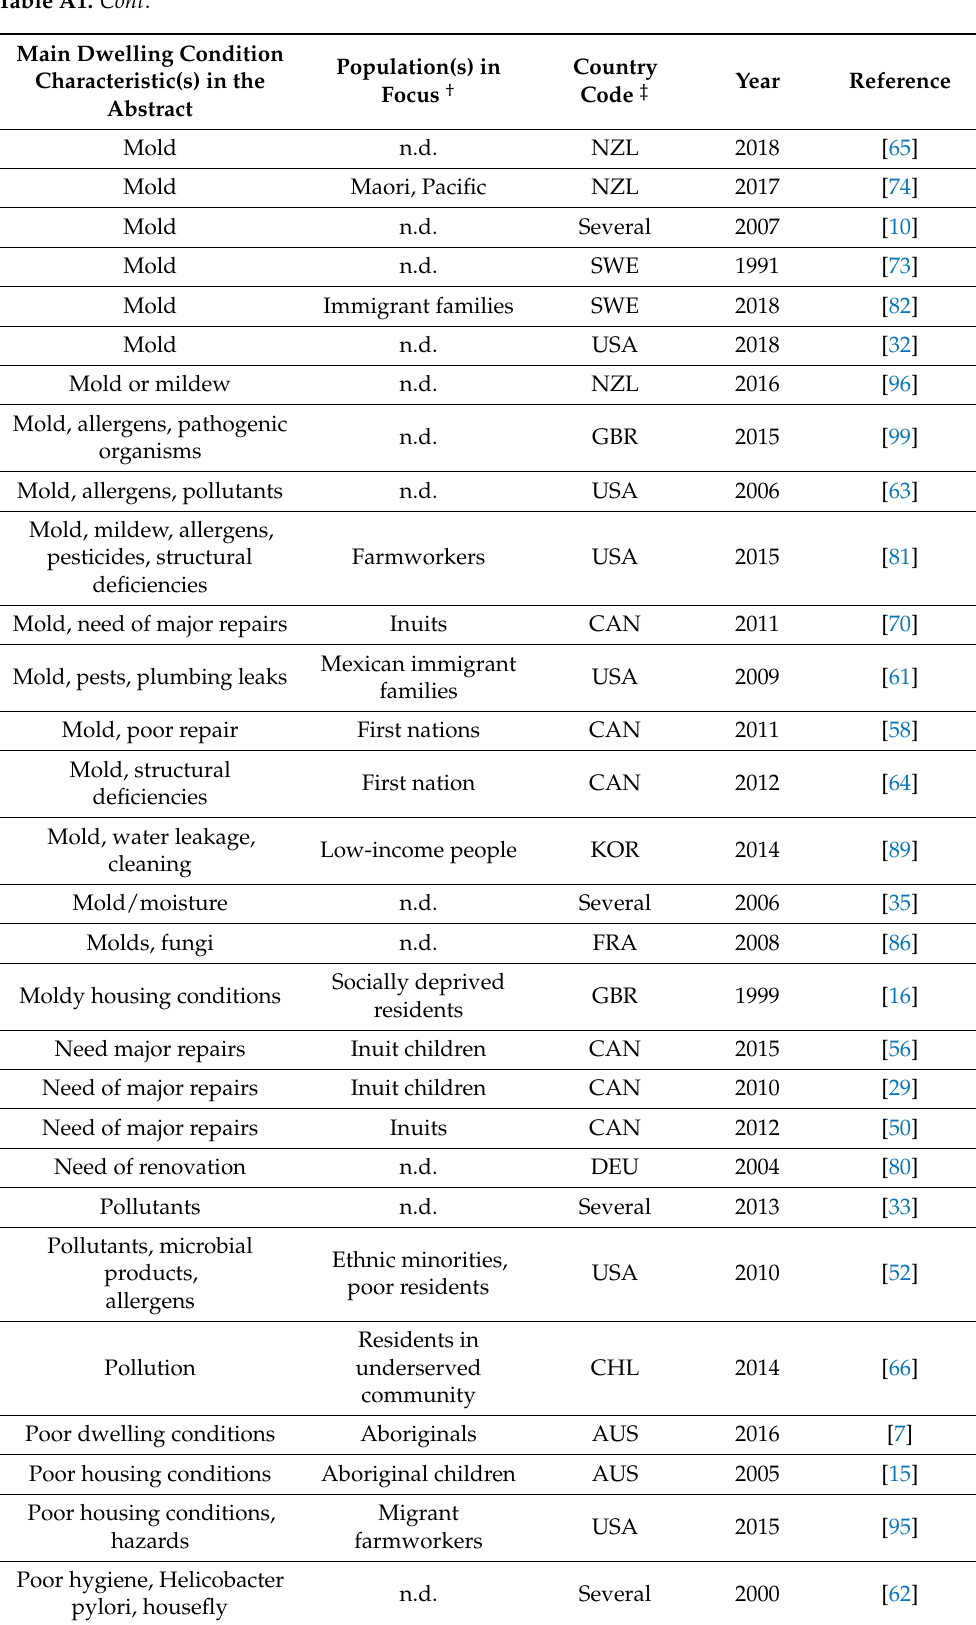
Population(s) in Country